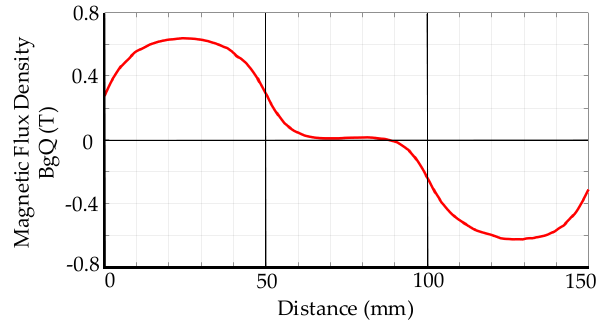
Figure 11. Magnetic flux density distribution in the air gap.